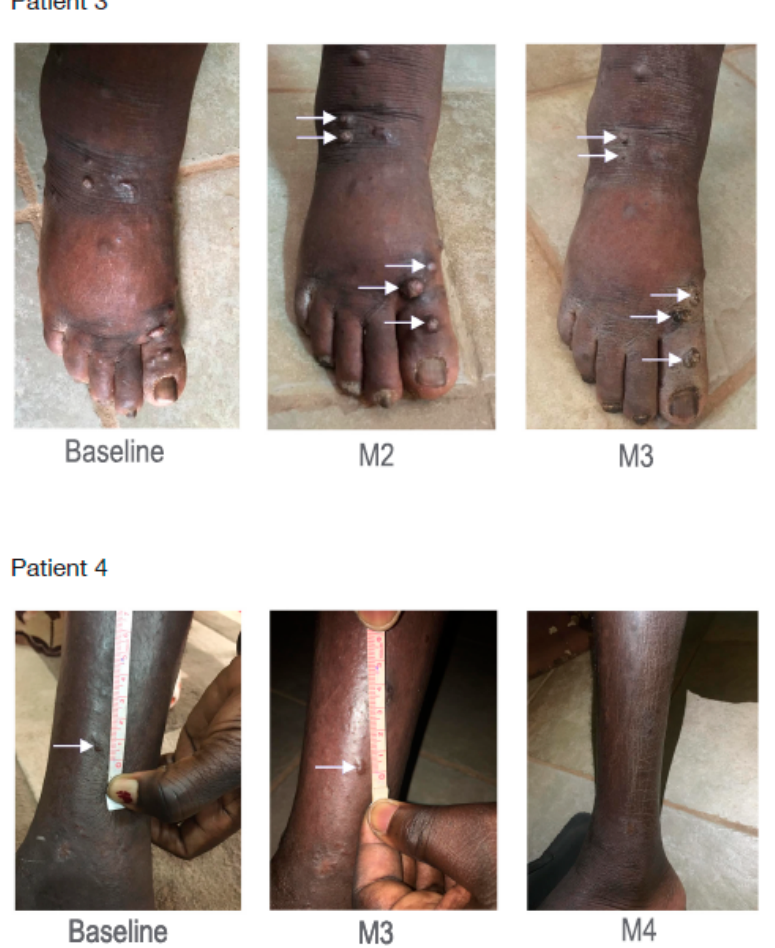
Figure 8. PQ reduced KS-related lesions and lymphedema. Clinical effects in patients 3 and 4: white arrows indicated KS lesions with clinically proven regression. These pictures also evidenced lymphedema improvement in both patients.